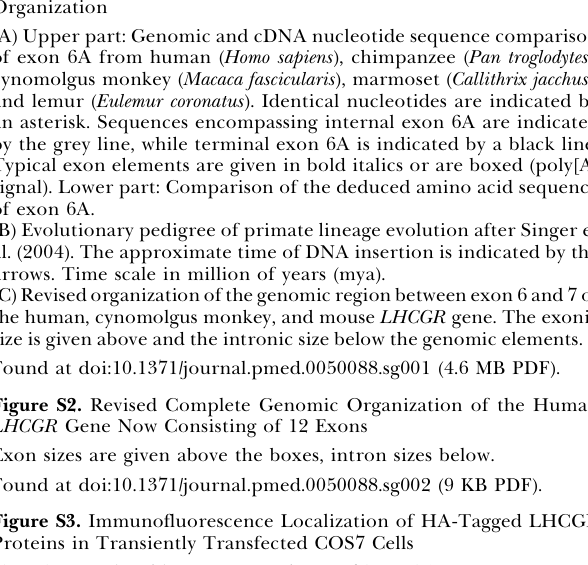
predominantly intracellular localization (A and B), while the full- length receptor is localized intracellularly ([C] left) and membrane bound ([C] right). Immunofluorescence was performed using an HA antibody (1:200, Santa Cruz) and an anti-mouse IgG-FITC–labeled secondary antibody (1:64 dilution) and was visualized using either an inverse epifluorescence microscope (Axioskop II, Zeiss, Germany, [A– C] left column) or a confocal microscope (Leica TCS-SL, Germany [A–C] right column). For the confocal analysis the cells were permeabilized. Bar indicates 50 l M. Found at doi:10.1371/journal.pmed.0050088.sg003 (173 KB PDF). Figure S4. Immunohistochemical Localization of the LHCGR in Human Testes Leydig cells are positive for LHCGR in normal spermatogenesis (A) and in the testes of a patient with LCH caused by an F194A inactivating mutation in LHCGR (see Gromoll J, et al. [2002] Eur J Endocrinol 147: 597] (B), whereas no LHCGR expression can be detected in Leydig cells of the A557C patient (C). a -smooth muscle actin staining was used as positive control for the same patient (D). Bar indicates 100 l M. Found at doi:10.1371/journal.pmed.0050088.sg004 (357 KB PDF). Figure S5. Functional Characterization of the T461I and the G558C Mutations (A) Signal transduction hCG-dependent cAMP-responsive luciferase activity measured in wild-type LHR (filled circle), LHR-T461I mutant receptor (square), and empty expression plasmid pSG5 (triangles) expressing HEK293 cells. The hCG response of the mutant LH receptor is almost completely absent. Renilla , control of transfection efficiency; RLU, relative luciferase units. Construction of the expression plasmid pSG5-LHRWT and pSG5-LHR-T461I, culture and transfection of HEK293 cells, and the determination of cAMP- dependent luciferase response were performed as described pre- viously (see Richter-Unruh A, et al. [2004] J Clin Endocrinol Metab 89: 5161). (B) Sequencing results of the compound heterozygous patient displaying the exon 6A and exon 11 mutations.